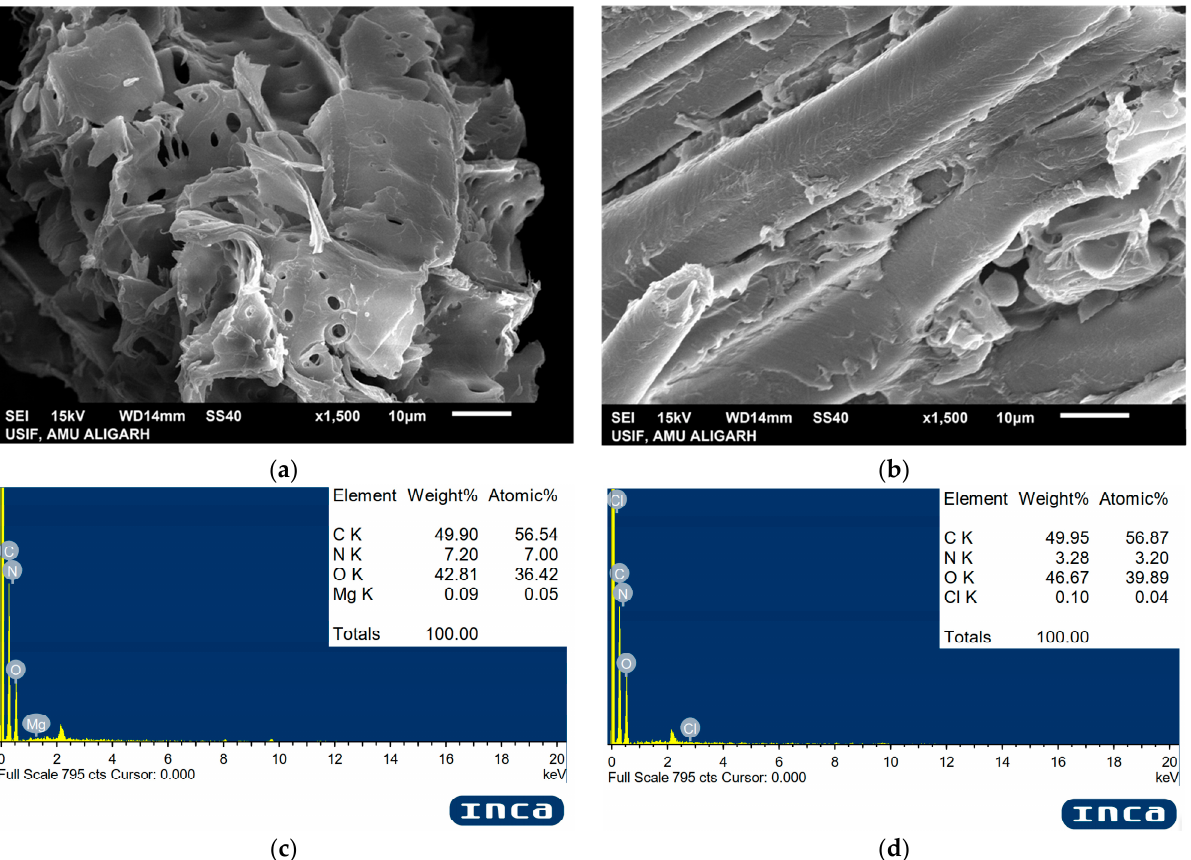
Figure 1. SEM micrographs (1500×) and EDXS outcomes of AISD adsorbent: before adsorption ( a , c ) and after adsorption ( b , d ).